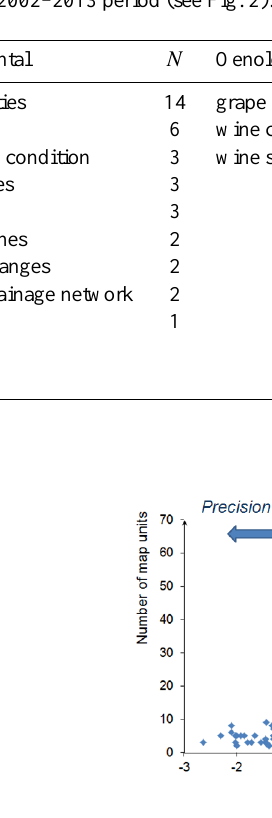
Table 1. Target variables of the zoning studies carried out over the 2002–2013 period (see Fig. 2).